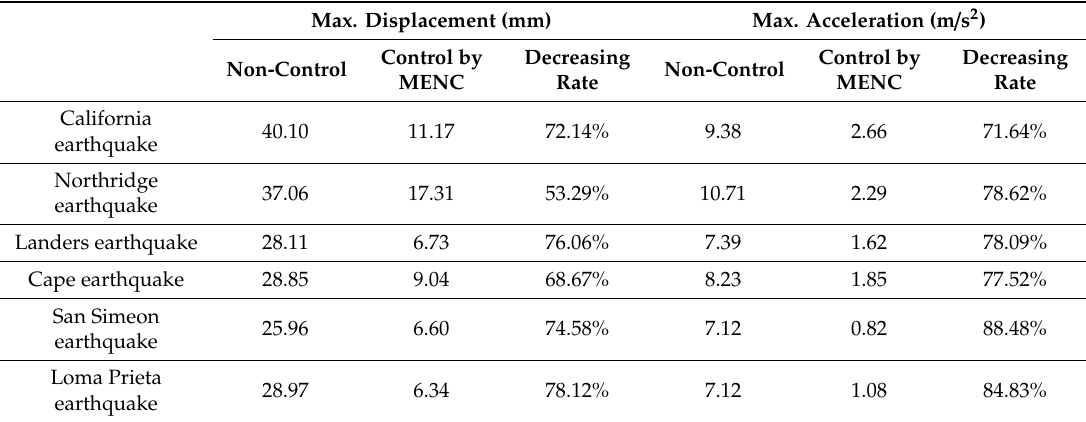
Table 3. Comparison of the maximum responses in control and non-control of the building structure under the seismic loads.